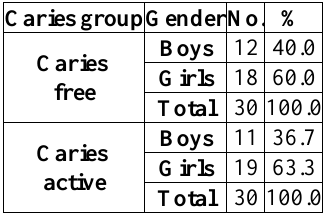
Table 1: Distribution of caries free and caries active children by gender